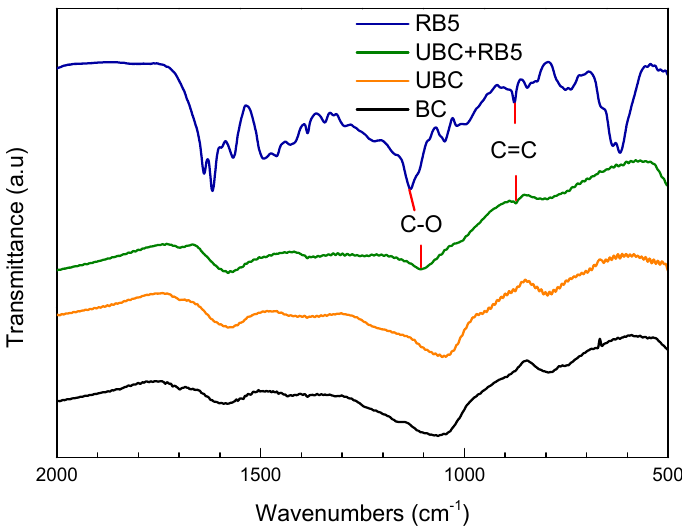
Figure 3. FTIR spectra of RB5, BC, UBC, and UBC absorbed RB5.